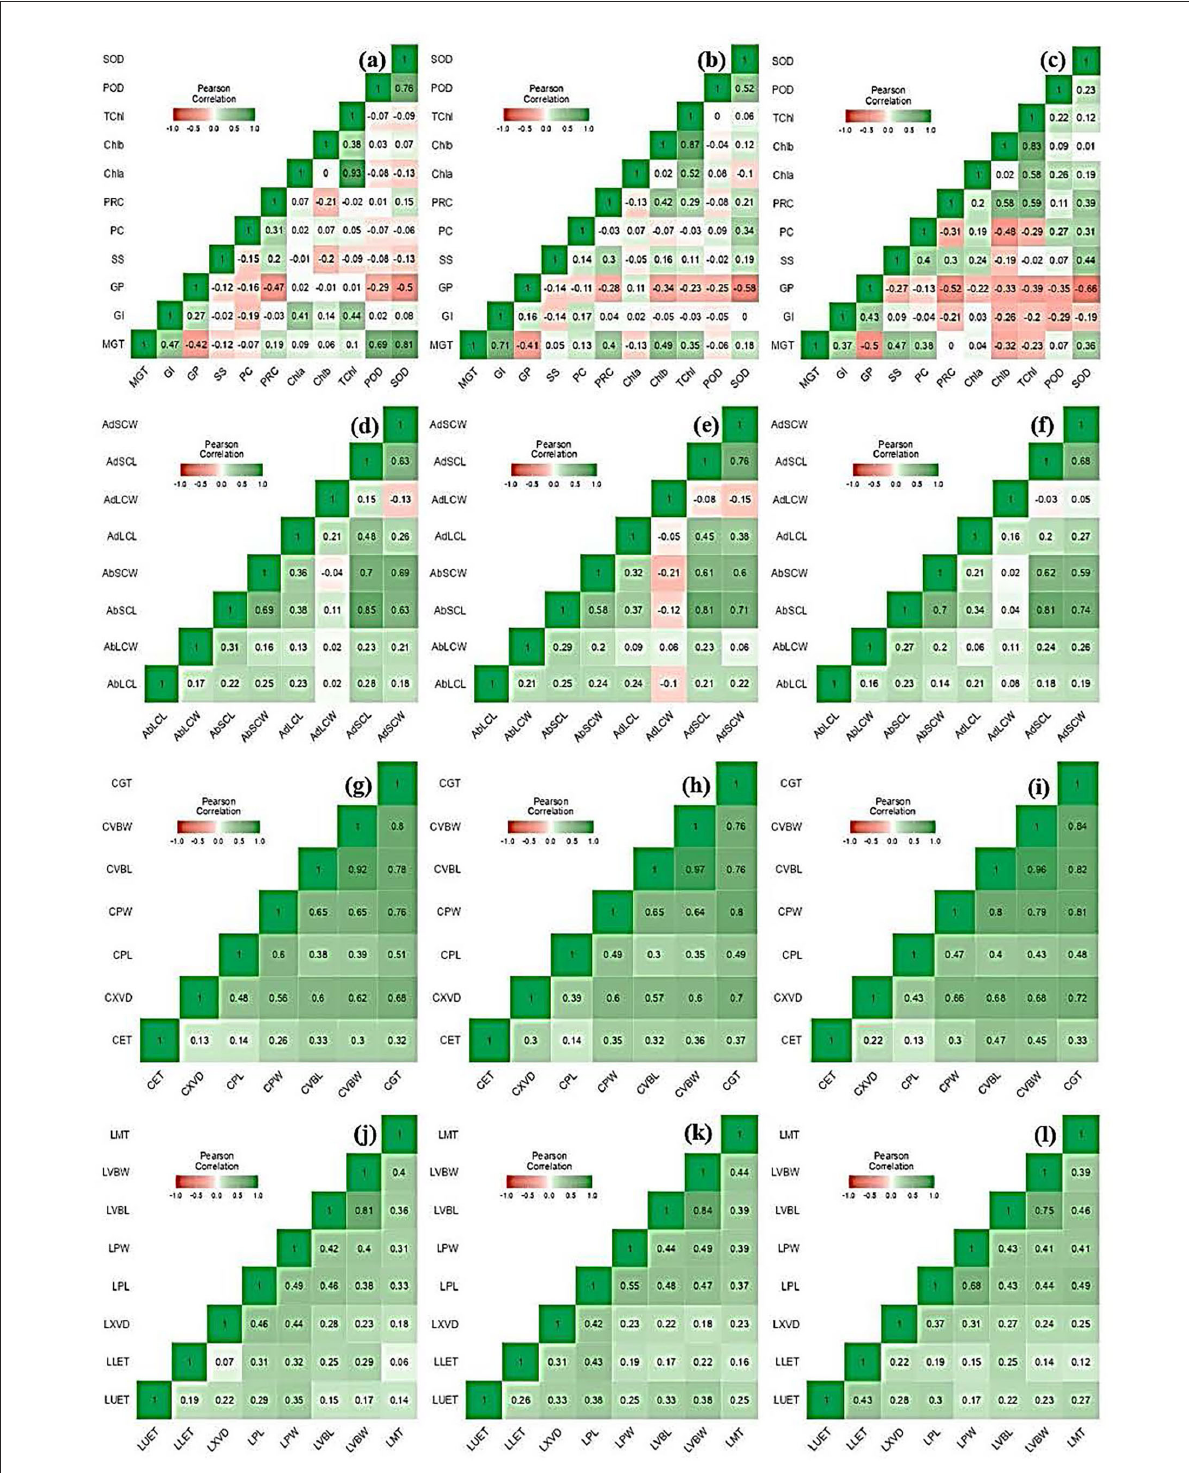
FIGURE4 Heatmap showing Pearson correlation coefficient and associated probabilities among Elymus species and wheat cultivars for the studied traits using ( n = 10) evaluated under osmotic (germination) moderate (MS; FC = 50%) and severe (SS; FC = 30%) water stress. (a) control, (b) MS, and (c) SS showing a relationship for morphological and physio biochemical traits; (d) control, (e) MS, and (f) SS showing a relationship for leaf micromorphological traits; (g) control, (h) MS, and (i) SS showing relationship for culm anatomical traits; and (j) control, (k) MS, and (l) SS showing relationship for anatomical and traits. The values in the color bar correspond to the Pearson correlation coefficient. Significant correlations are shown in green (positive) and red (negative) colors at p ≤ 0.05, ≤ 0.01, ≤ 0.001,